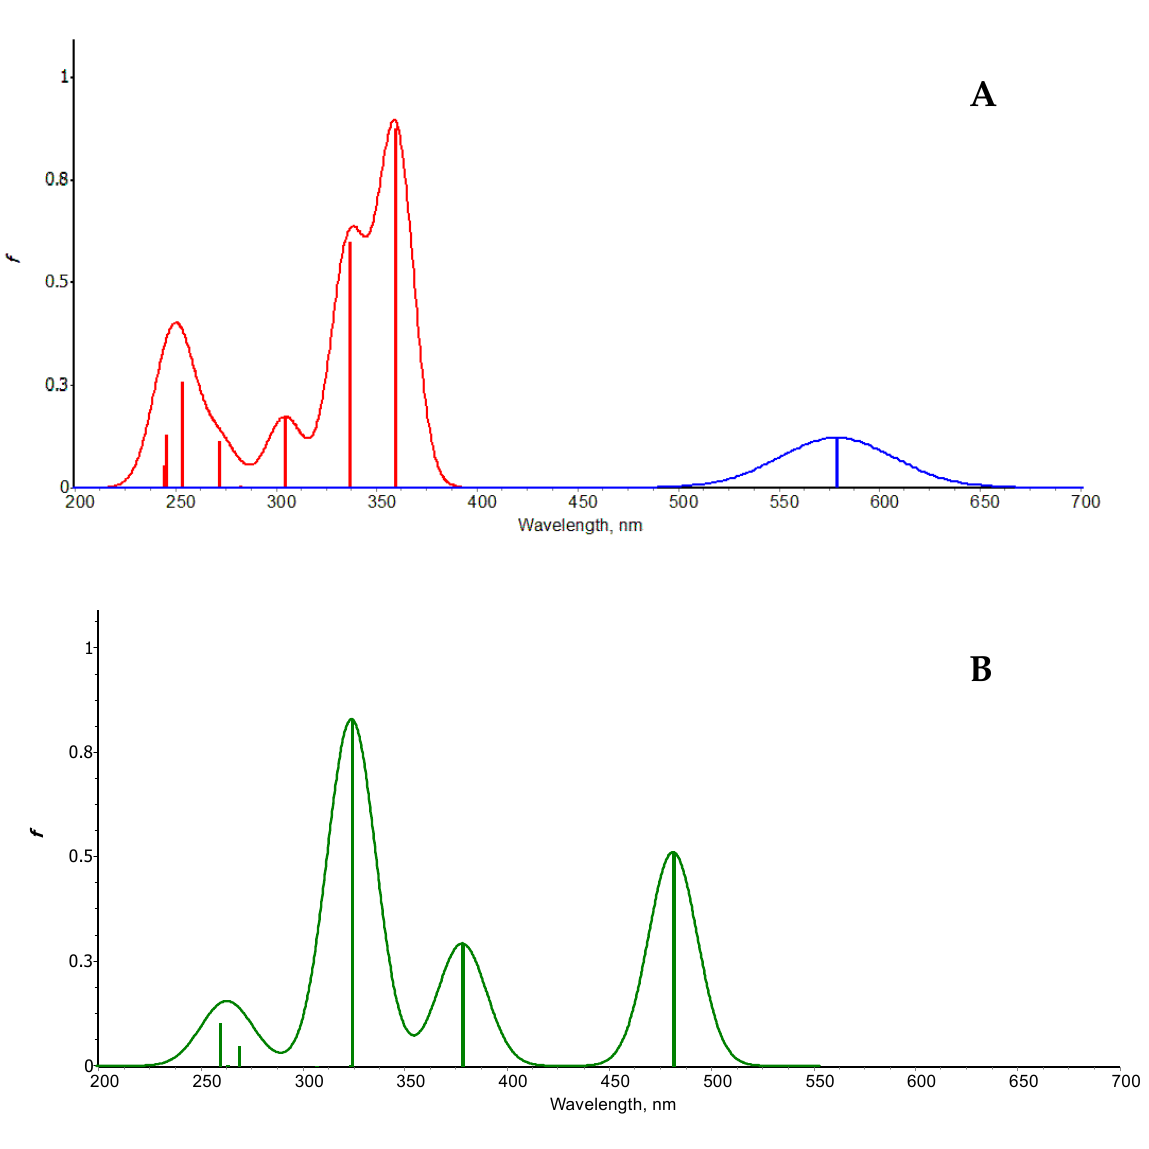
Figure 2. TDDFT simulated spectra of ( A ) H 2 L in DMSO. Red—absorption, blue—emission (after ESPT) and ( B ) HL − in DMSO. f is the oscillator strength.